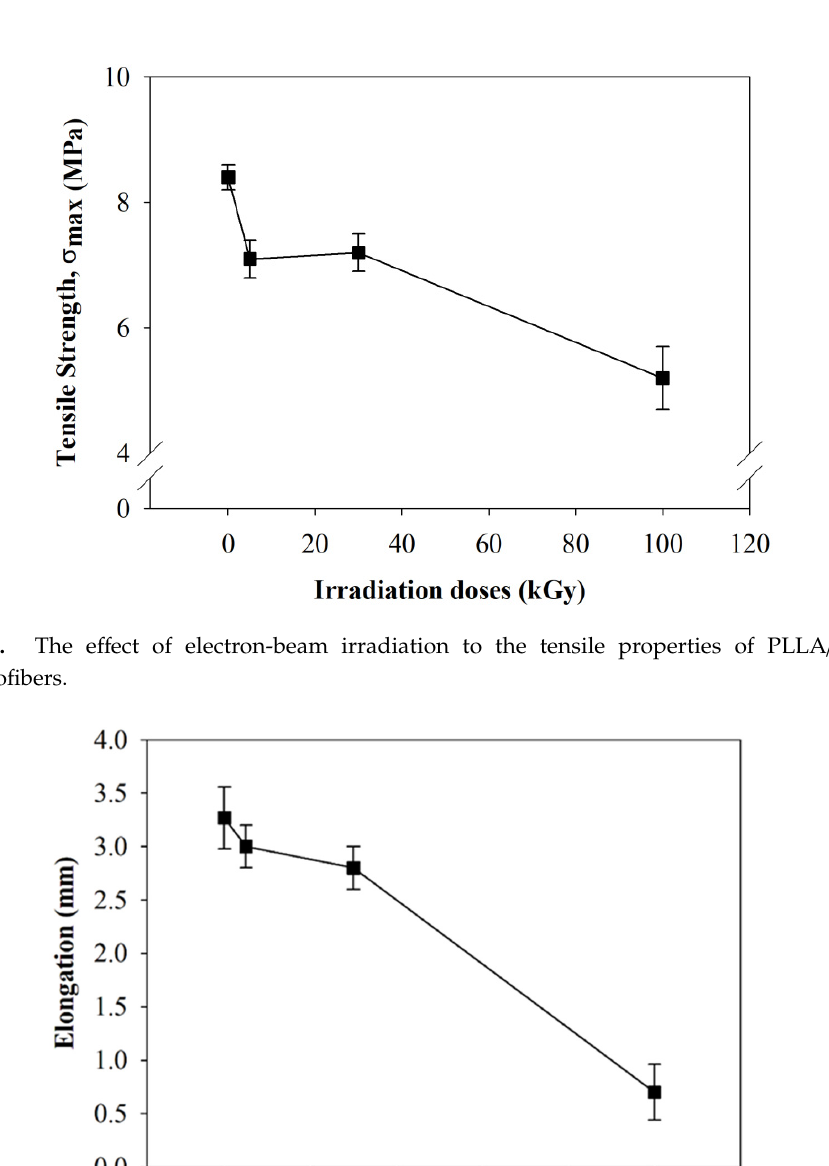
Figure 9. The effect of electron-beam irradiation to the elongation of PLLA/CMS/ β -TCP nanofibers.